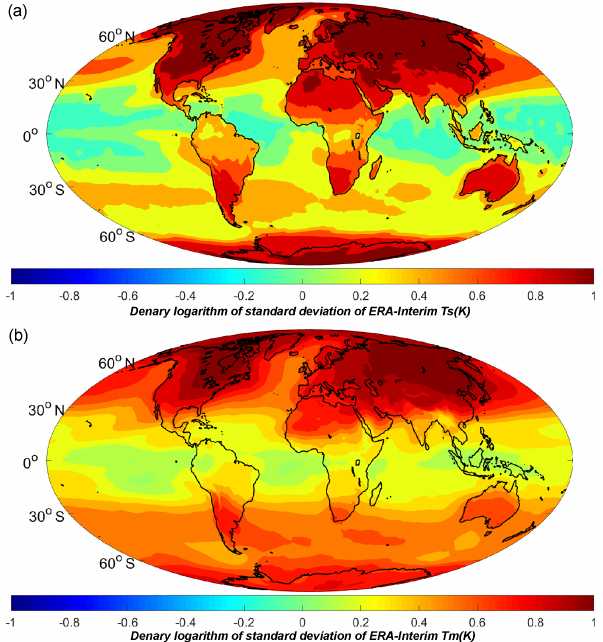
Figure 2. Denary logarithm of the standard deviation of (a) T s and (b) T m generated from the ERA-Interim data covering the years 2009 to 2012. Temperature unit is Kelvin.